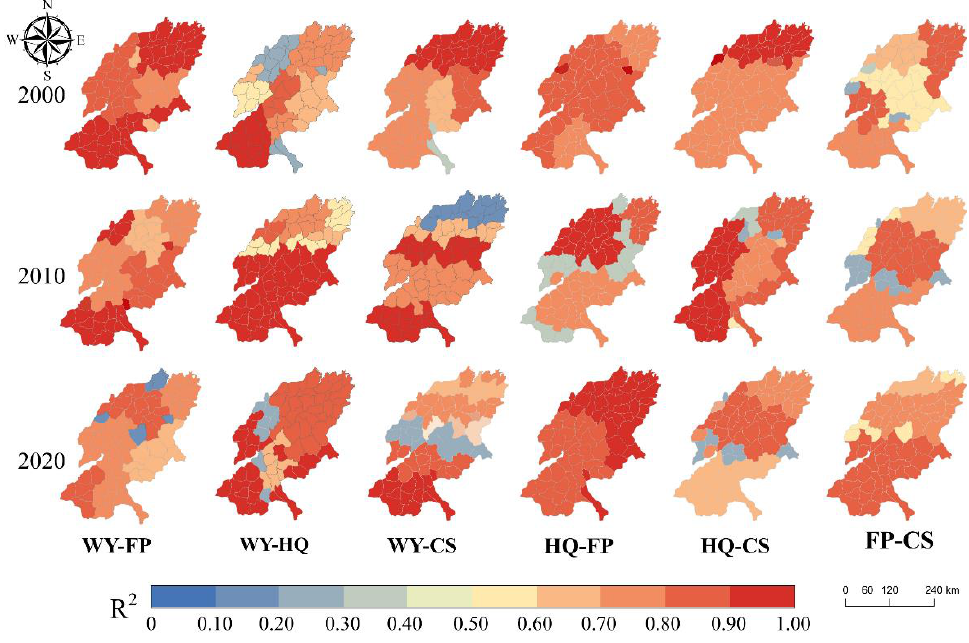
Figure 9. The local R2 of the GWR model.